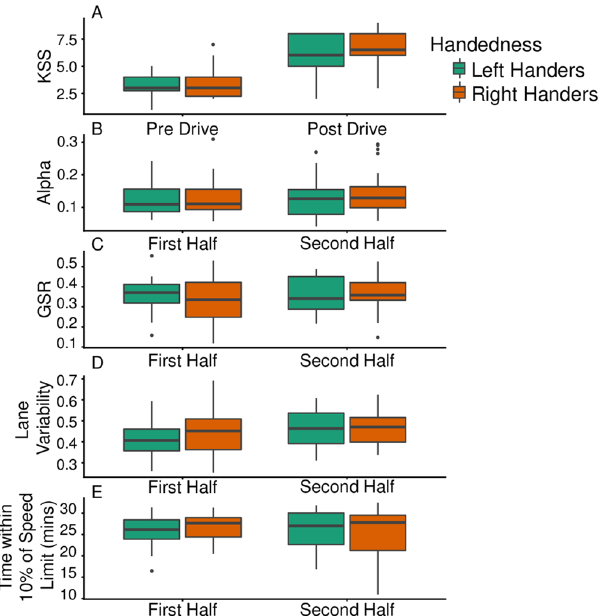
Figure 2. Changes in KSS ( A ), alpha ( B ), GSR ( C ), lane variability ( D ) and time spent within 10% of the speed limit ( E ), separated by